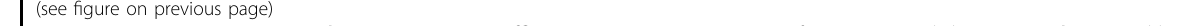
with urgent unmet needs.